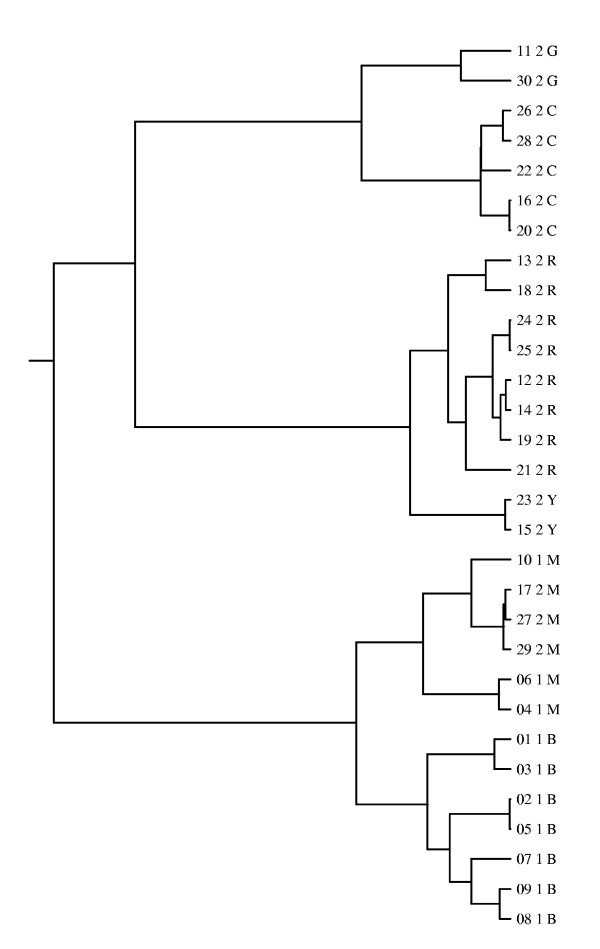
Evolutionary history for the 6th fragment in the coalescent simulation. Evolutionary tree for the sixth fragment in the coalescent simulation. The leaf node labels are as in Figure 1. This tree was used as the left-side tree in the repetitive phylogenetic simulation experiments. The right-side trees corresponding to the different recombination types were obtained as follows: 1) (recent recombination with a distant relative) strain 27 was moved to the same branch with strain 19. 2) (recent recombination with a close relative) strain 27 was moved to the same branch with strain 7. 3) (old recombination) the branch containing all the cyan strains was moved to become a part of the branch containing the red strains. 4) (recombination involving a miniature cluster) strain 11 was moved to the same branch with strain 19. 5) (recombined fragment obtained from outside of the populations in data) strain 27 was moved to its own branch, which joins the rest of the tree close to the root.